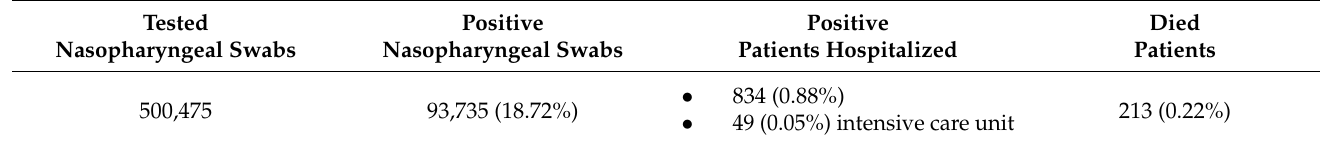
Table 1. Positivity, hospitalization and death rate data of Ragusa area